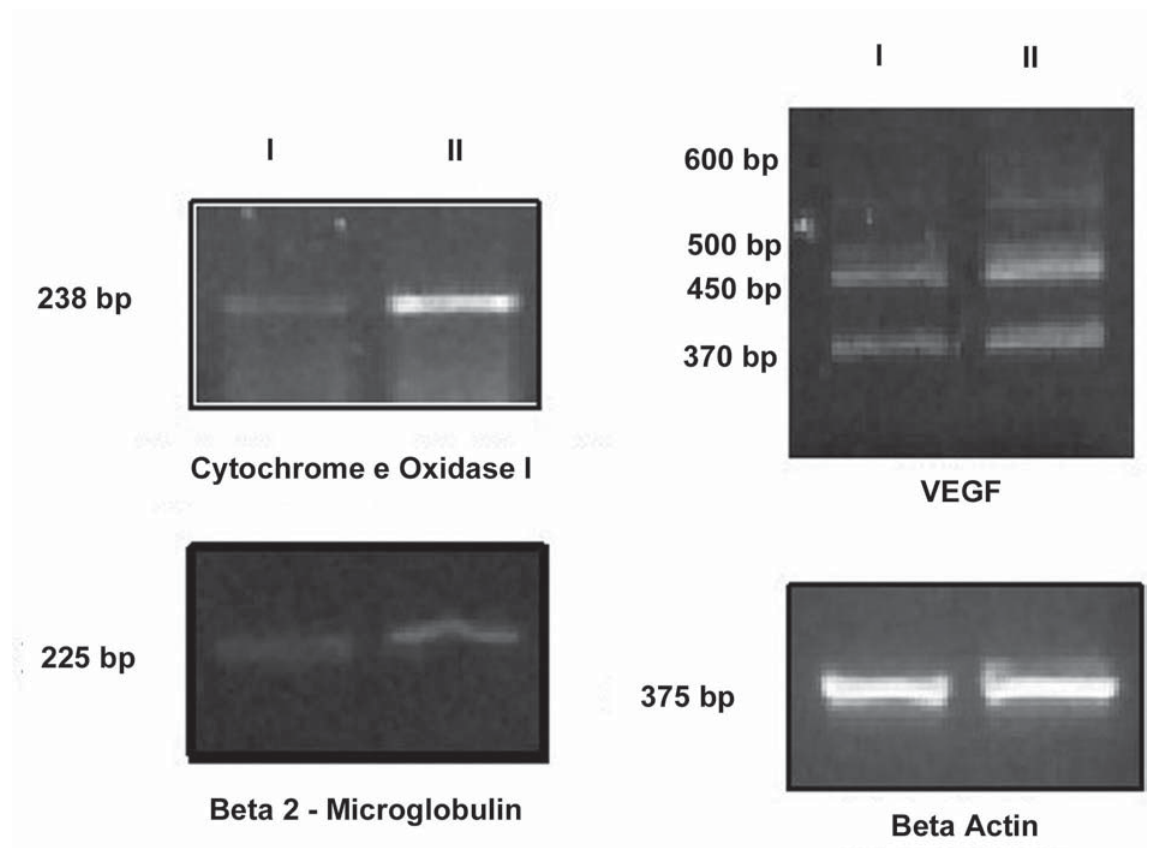
Figure 1 – Validation of array data by semi-quantitative RT-PCR. Beta Actin was housekeeping